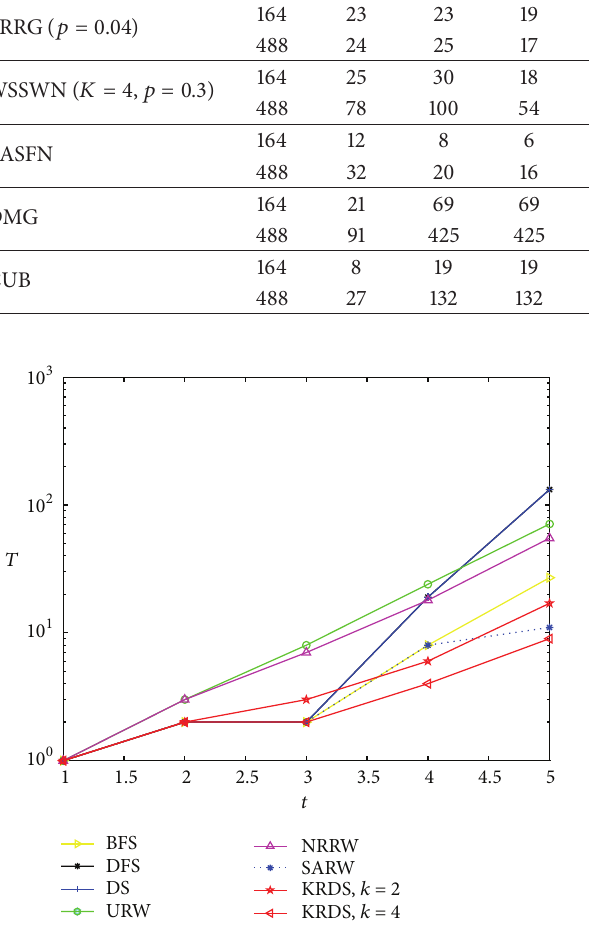
Figure 12: Plot of the average number 𝑇 of search steps versus the number 𝑡 of iterations of the CUB in the semilog